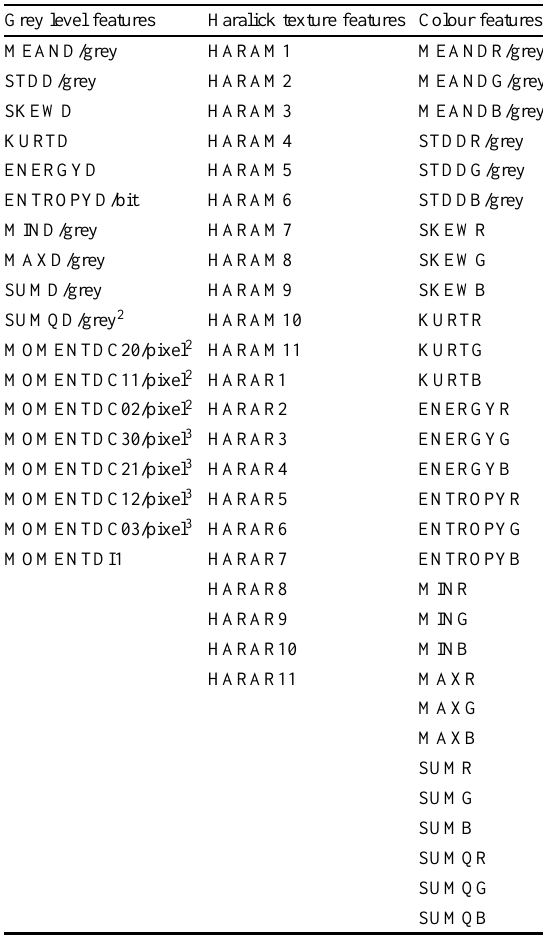
Measurement features obtained for each element. For detailed defi- nition see [1] Grey level features Haralick texture features Colour